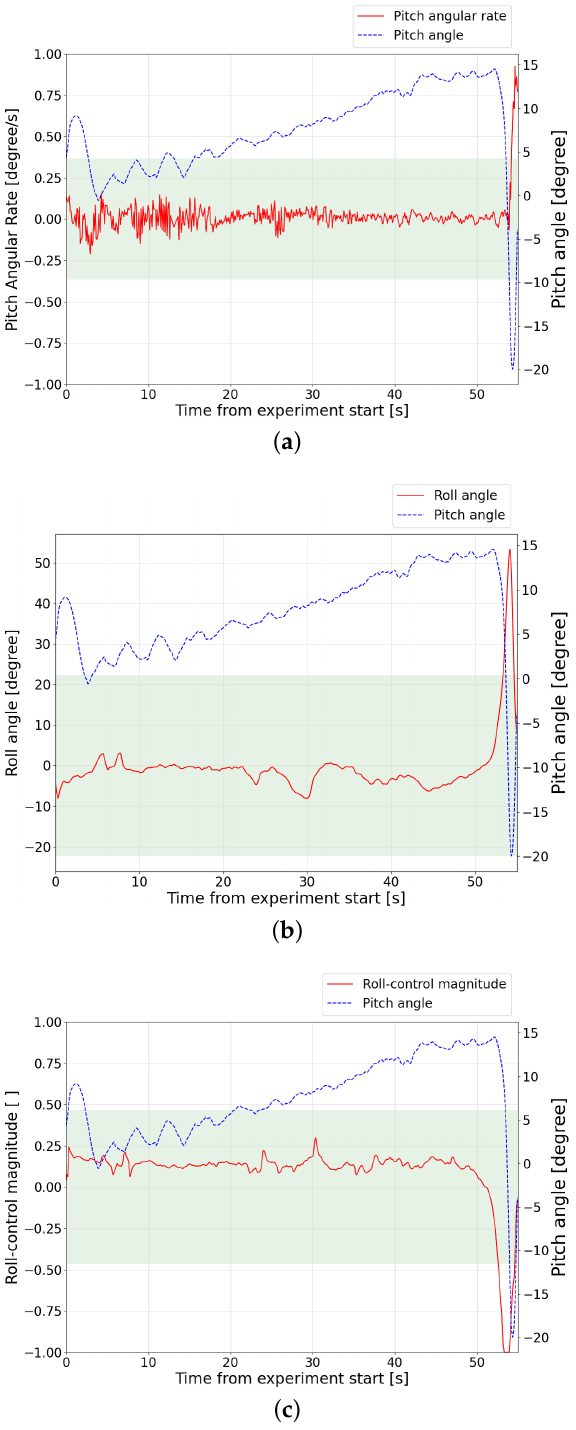
Figure 11. Time series plots of the pitch rate, the roll angle, and the roll-control magnitude. ( a ) Pitch angle rate, ( b ) Roll angle, ( c ) Roll-control